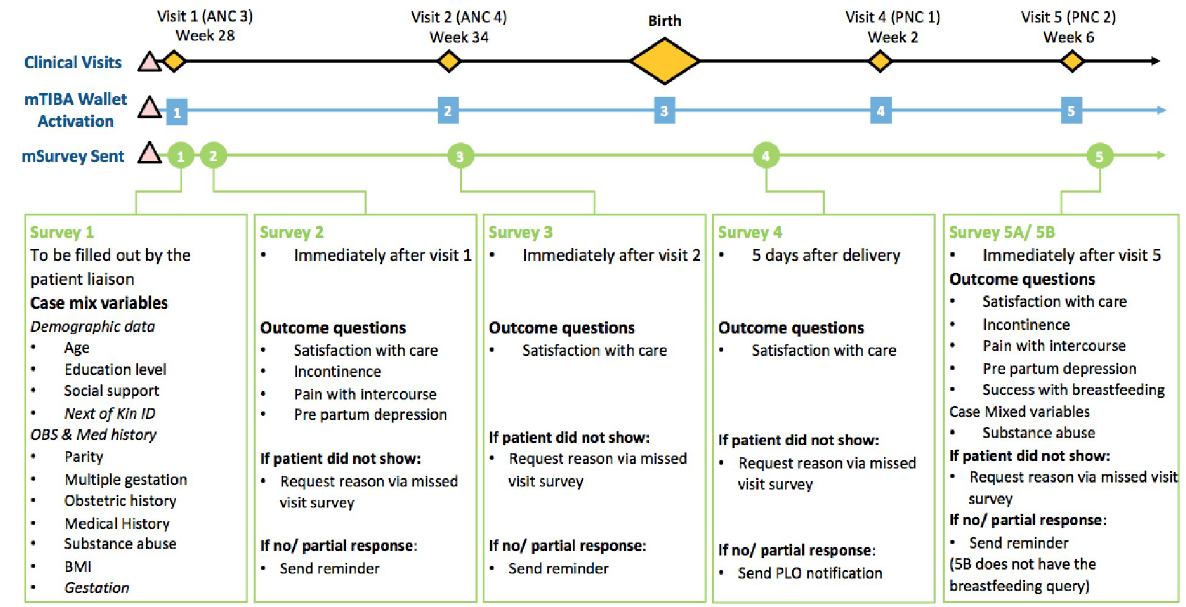
Fig 2. Patient appointment and data flow diagram for women enrolled in the